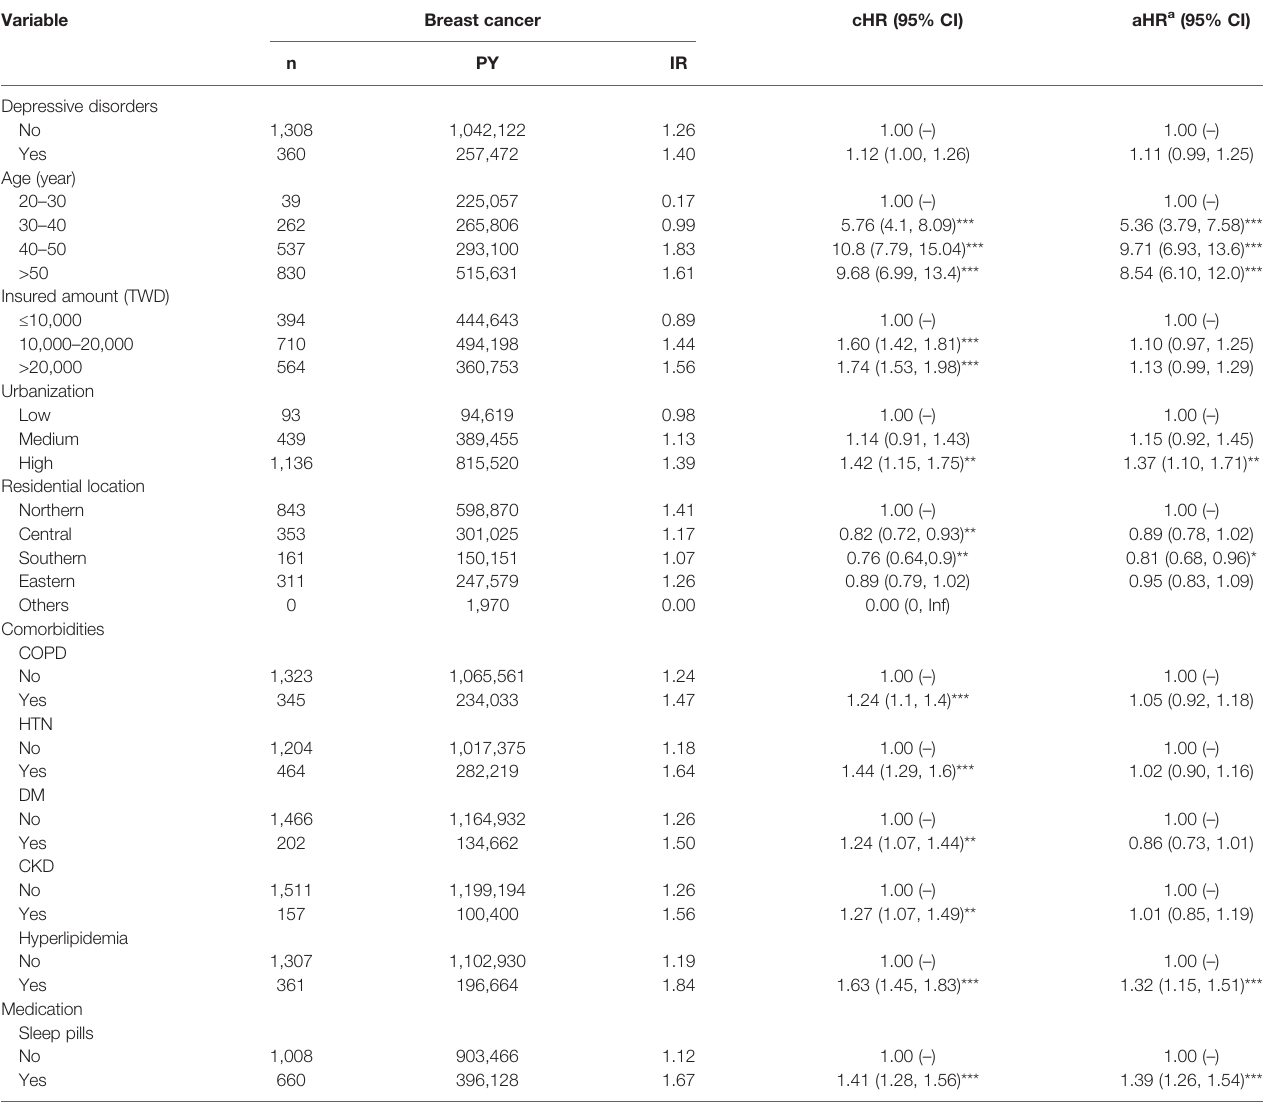
TABLE 5 | The incidence rates and hazard ratios of breast cancer in depressive disorder cohort. Variable Breast cancer cHR (95%